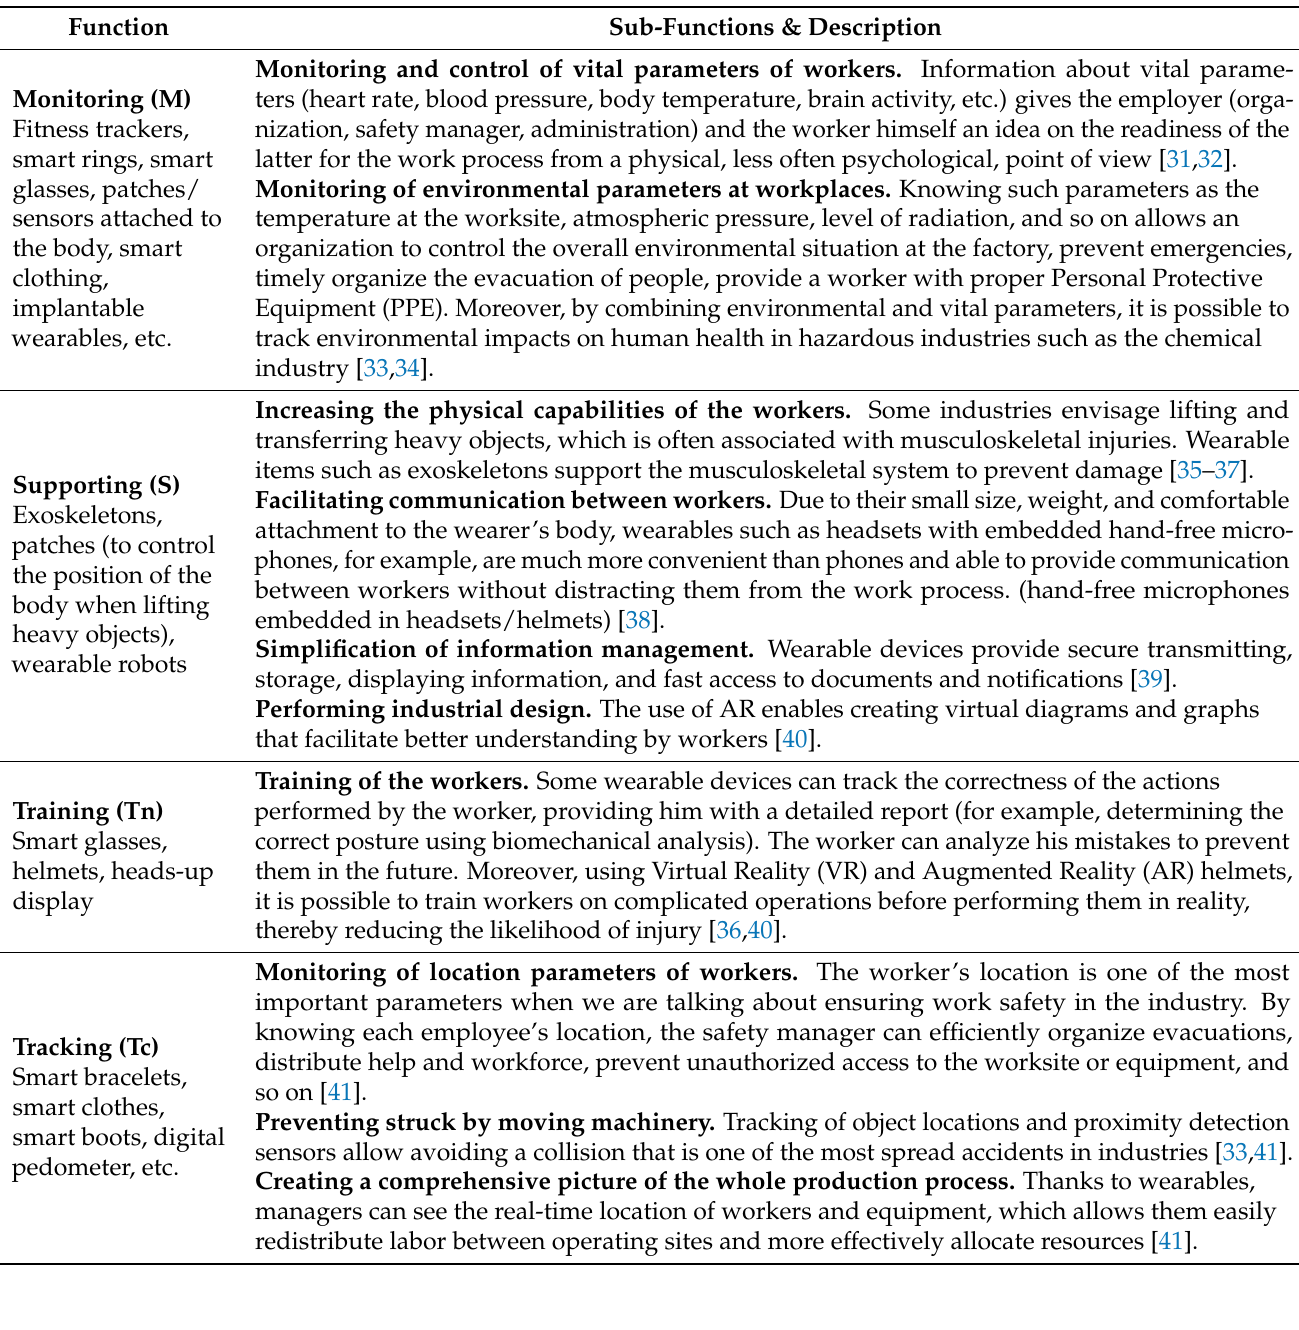
Table 1. Classification of industrial wearable